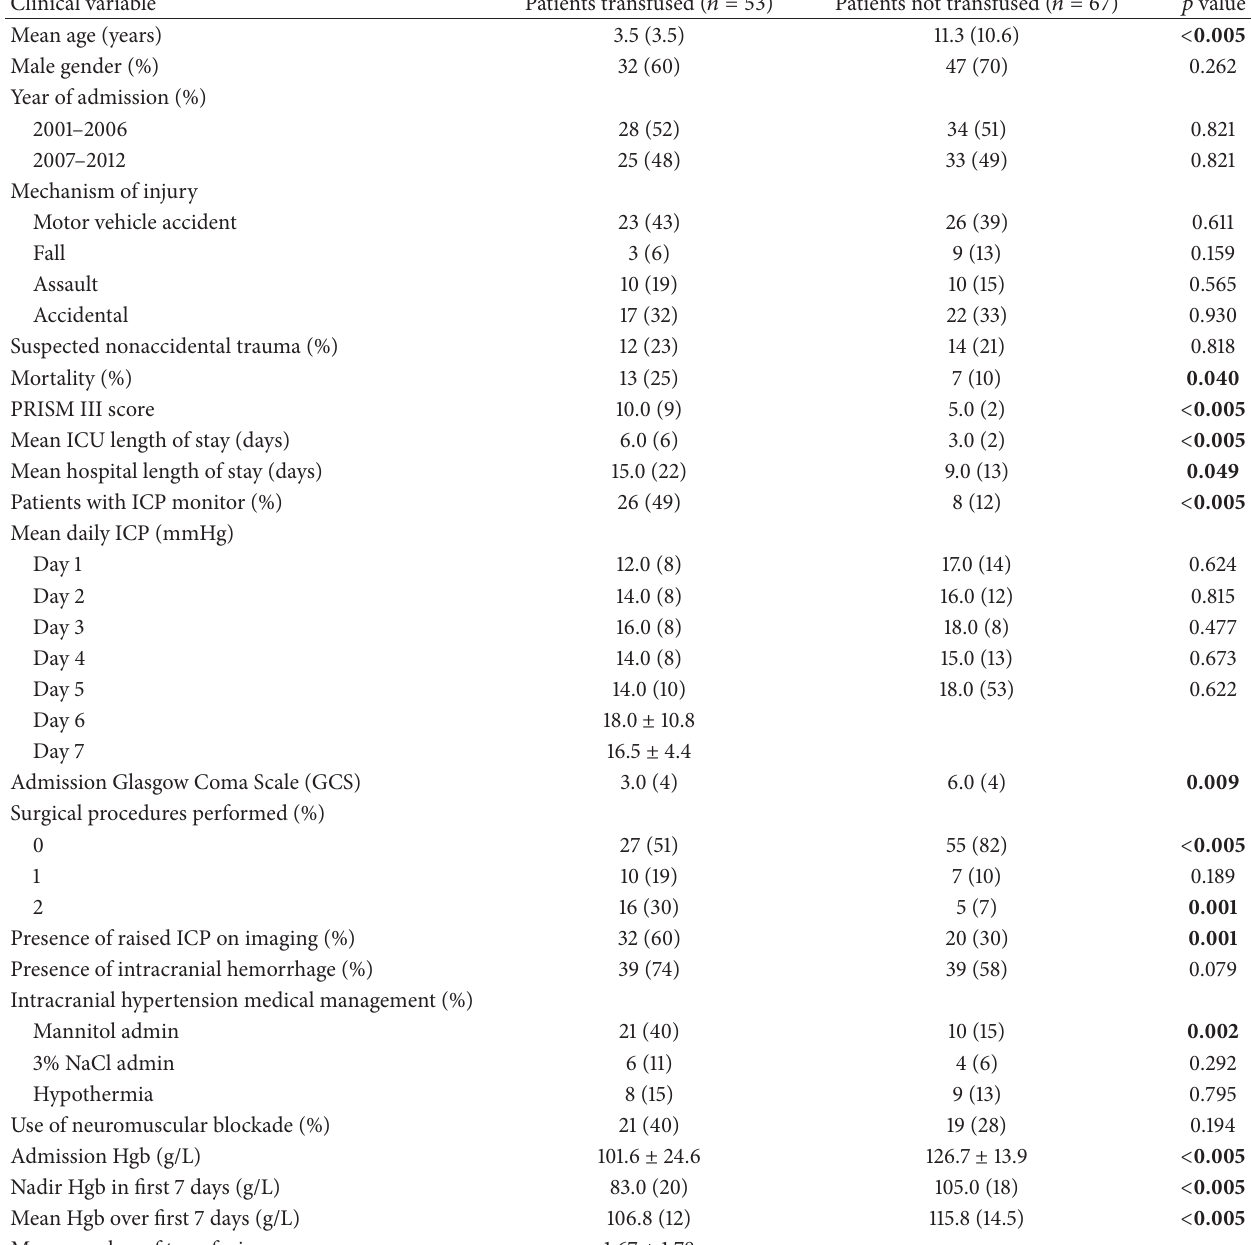
Table 1: Demographic information. GCS: Glasgow Coma Scale. Hgb: hemoglobin. PRISM III: pediatric risk of mortality III score. SD: standard deviation. Values represented as “ x ( y )” are the median (interquartile range). Values with “ x ± y ” are mean ±